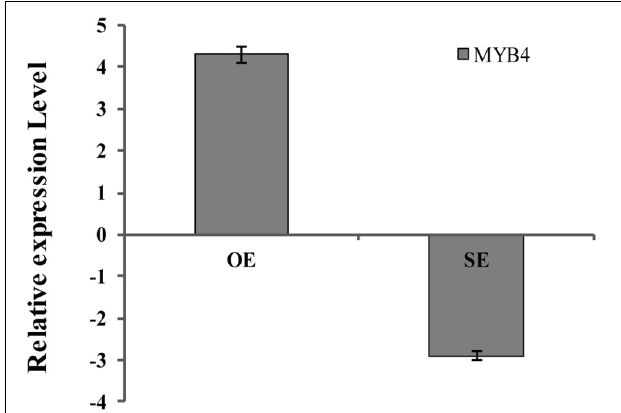
FIGURE 6 | Analysis of BpMYB4 expression in birch after transient transformation. The overexpression vector 35S: BpMYB4 (OE) and the inhibitory expression vector pFGC5941-BpMYB4 (SE) were transformed into birch seedlings by infection to make the vector transiently expressed in the plant, and the expression analysis of BpMYB4 was performed by real-time quantitative